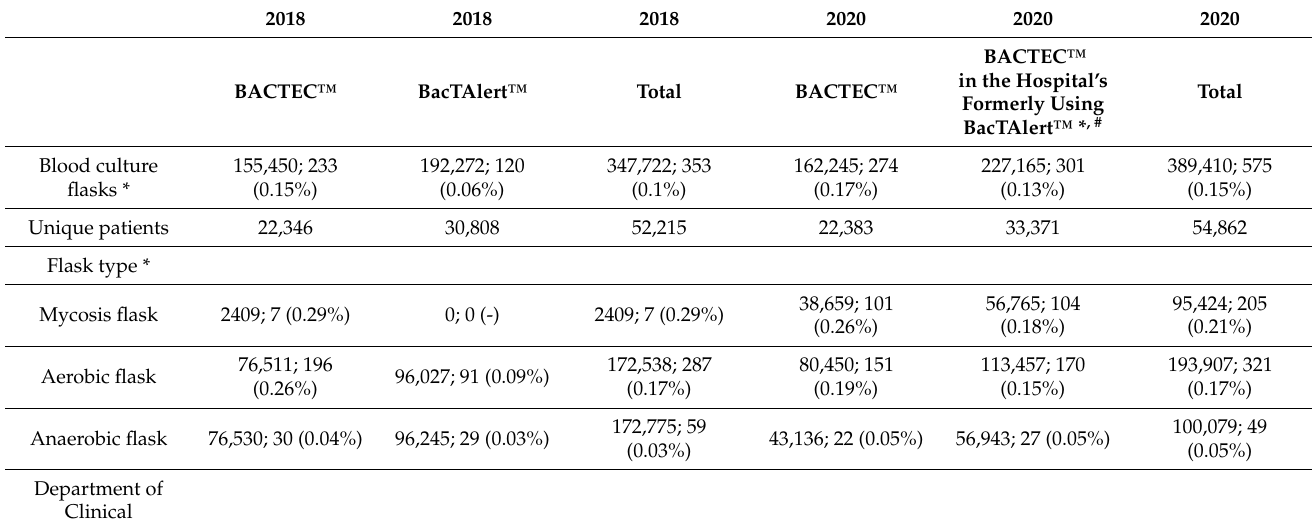
Table 1. Characteristics of the study population individual